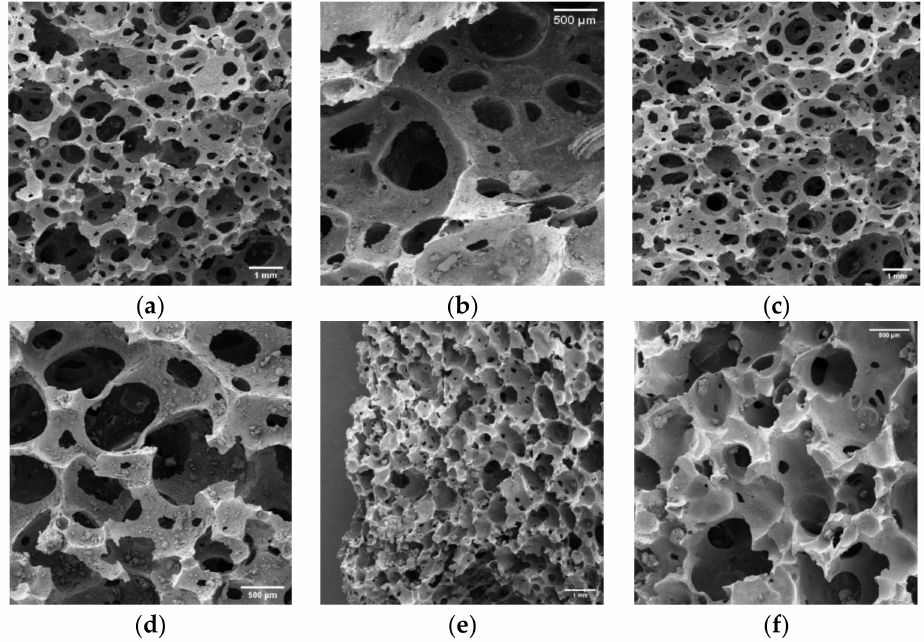
Figure 14. ( a , b ) PF1 after 5 months in a natural aerobic soil environment, ( c , d ) PF1 after 5 months in a laboratory aerobic soil environment, and ( e , f ) PF2 after 2 months in an aerobic soil